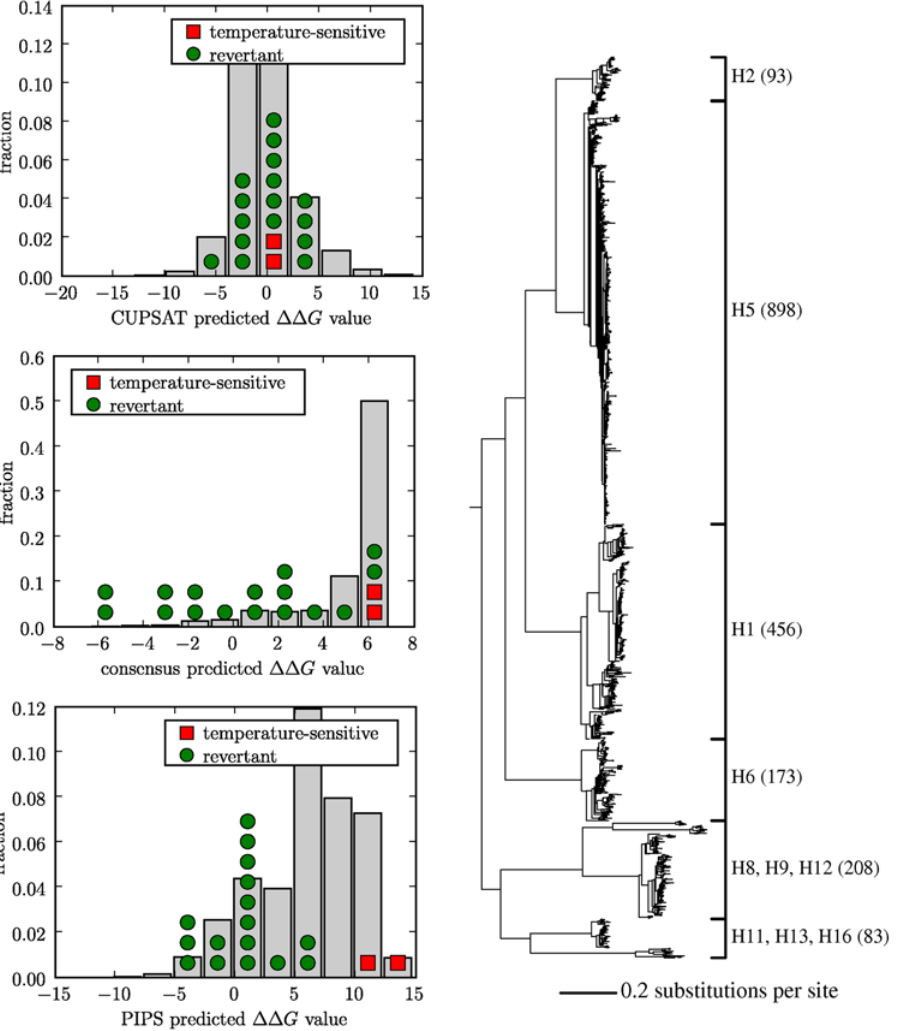
Figure 9. Predicted stability effects of known temperature-sensitive and revertant mutations to H1 hemagglutinin. In the plots at left, bars indicate the distribution of predicted DD G values for all single mutations, while symbols show predicted values for the temperature-sensitive and revertant mutations. At right is the phylogenetic tree utilized by the PIPS program. The tree labels give the hemagglutinin subtypes and corresponding numbers of sequences. The PIPS predictions are made using the informative priors.